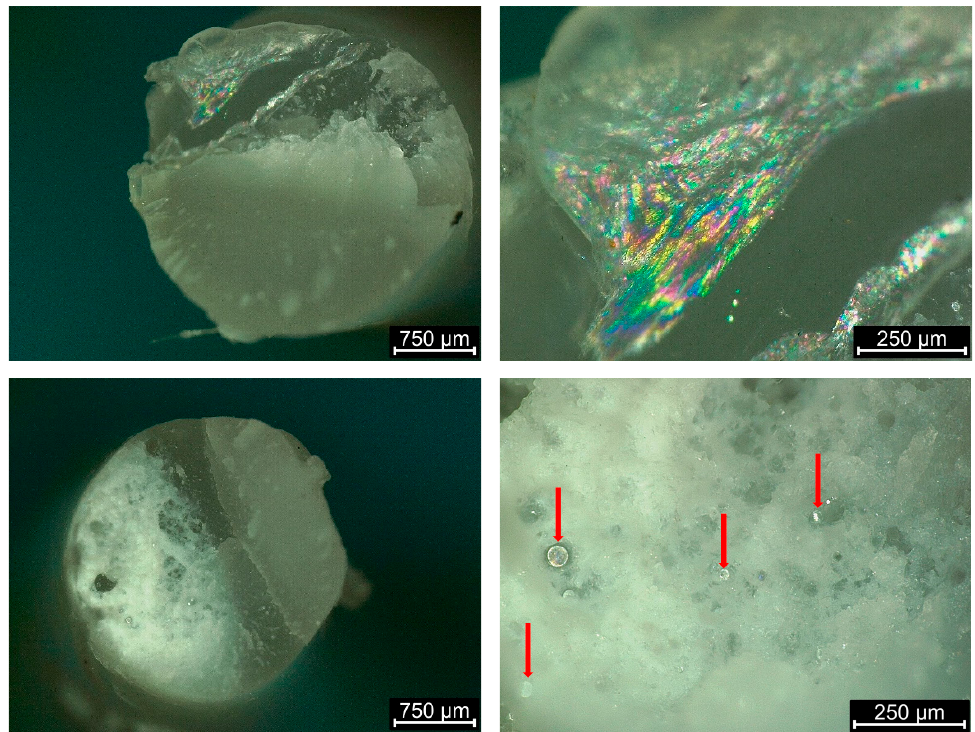
Figure 1. Optical images of pure PCL filament at low ( left above) and high magnitude ( right above). Below is a filament with 10 wt% of glass beads. The red arrow points to the placement of glass beads inside the PCL filament.